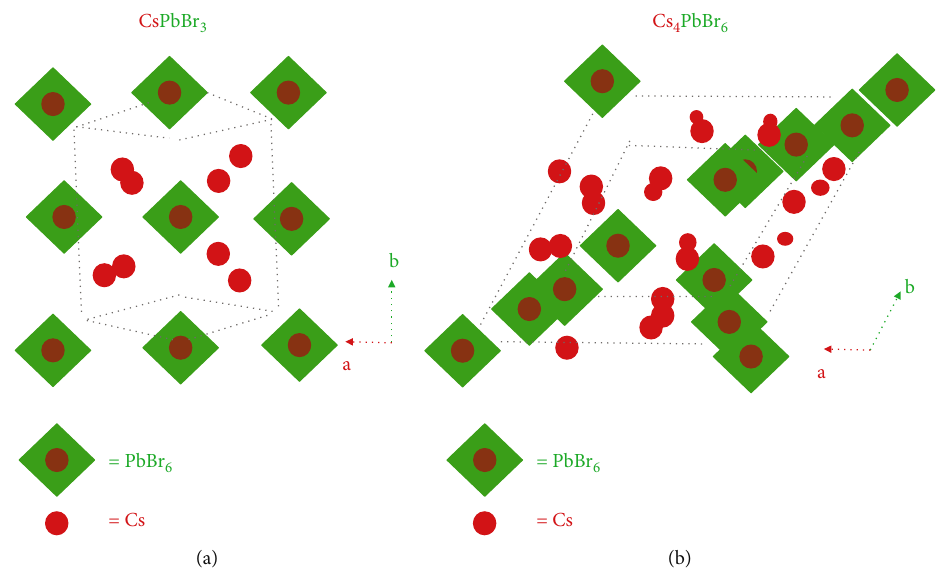
Figure 2: Second-order RC equivalent circuit